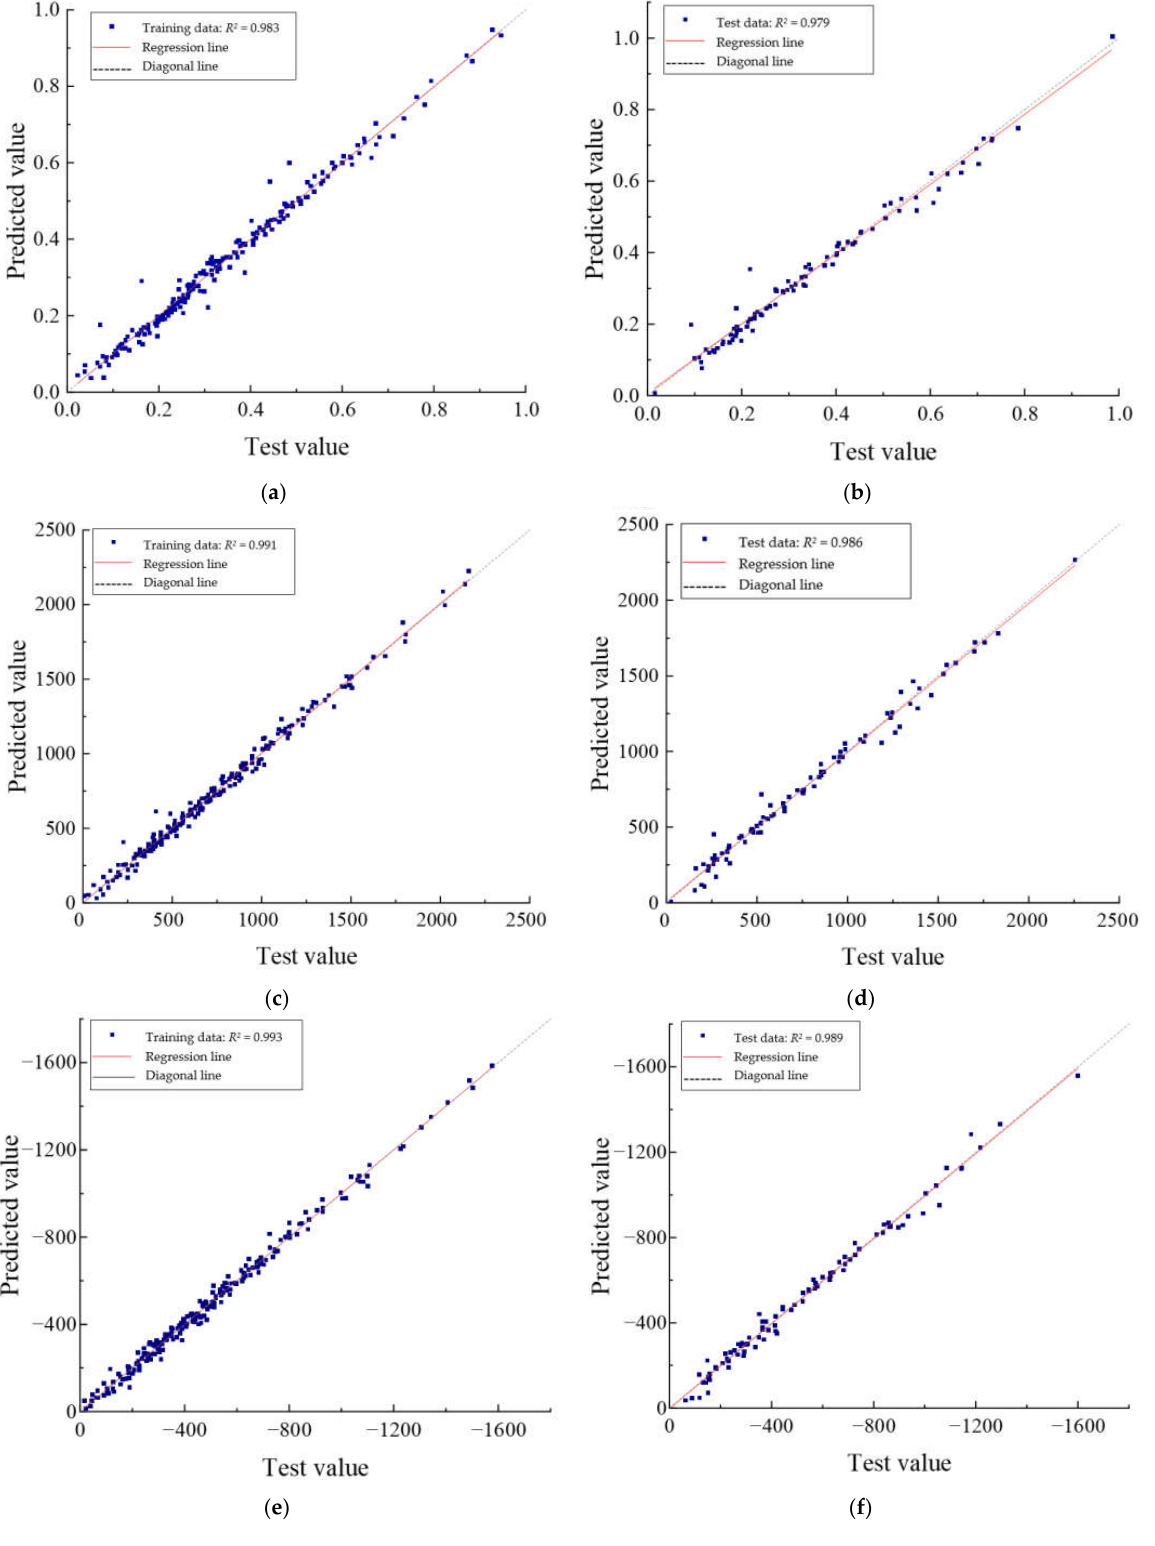
Figure 9. Correlation analysis between test and predicted values of fatigue performance of RC specimen beams: ( a ) mid-span deflection prediction for training data; ( b ) mid-span deflection prediction for test data; ( c ) reinforcement strain prediction for training data; ( d ) reinforcement strain prediction for test data; ( e ) concrete strain prediction for training data; and ( f ) concrete strain prediction for test